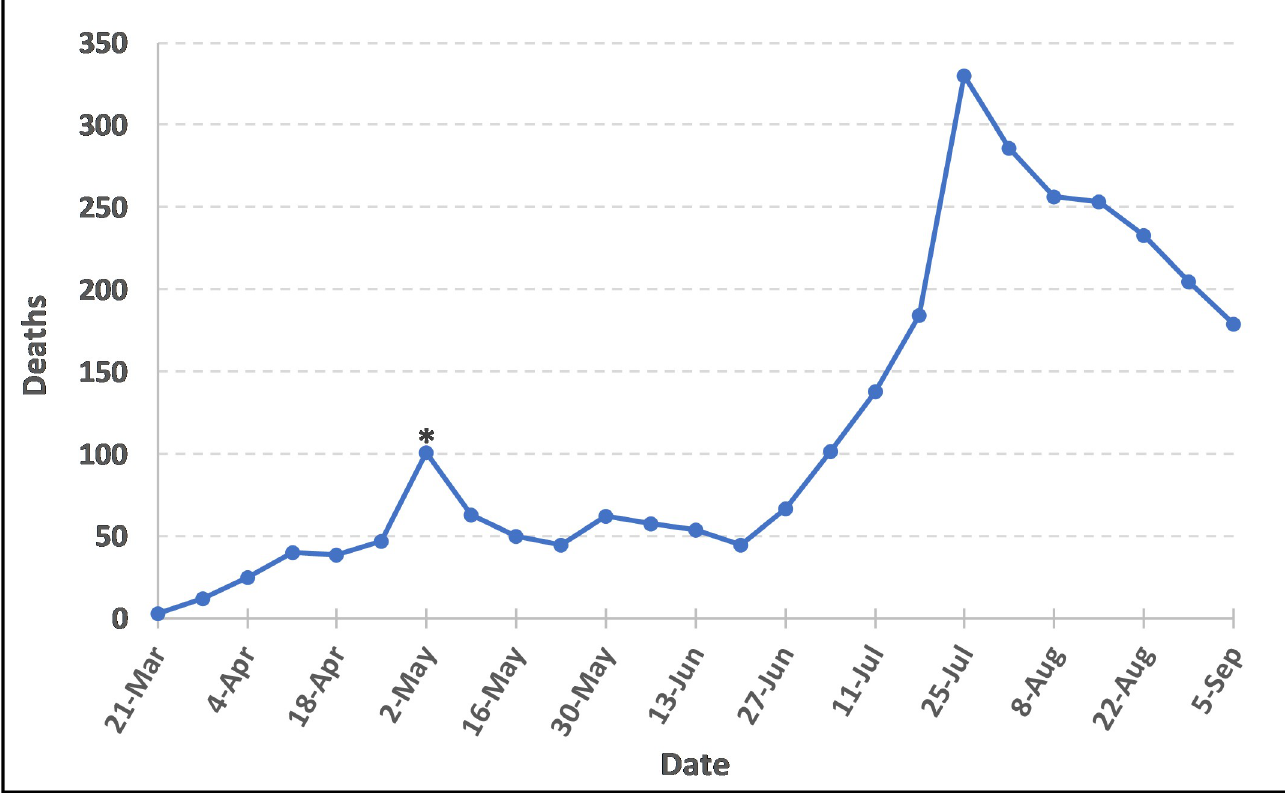
Fig 3. New South Carolina COVID-19 deaths per epi week (March 6 th –September 5 th , 2020). The � is a reporting artifact due to technical computer system delays in Electronic Laboratory Reporting to the state. The estimated number for the week is around 72.